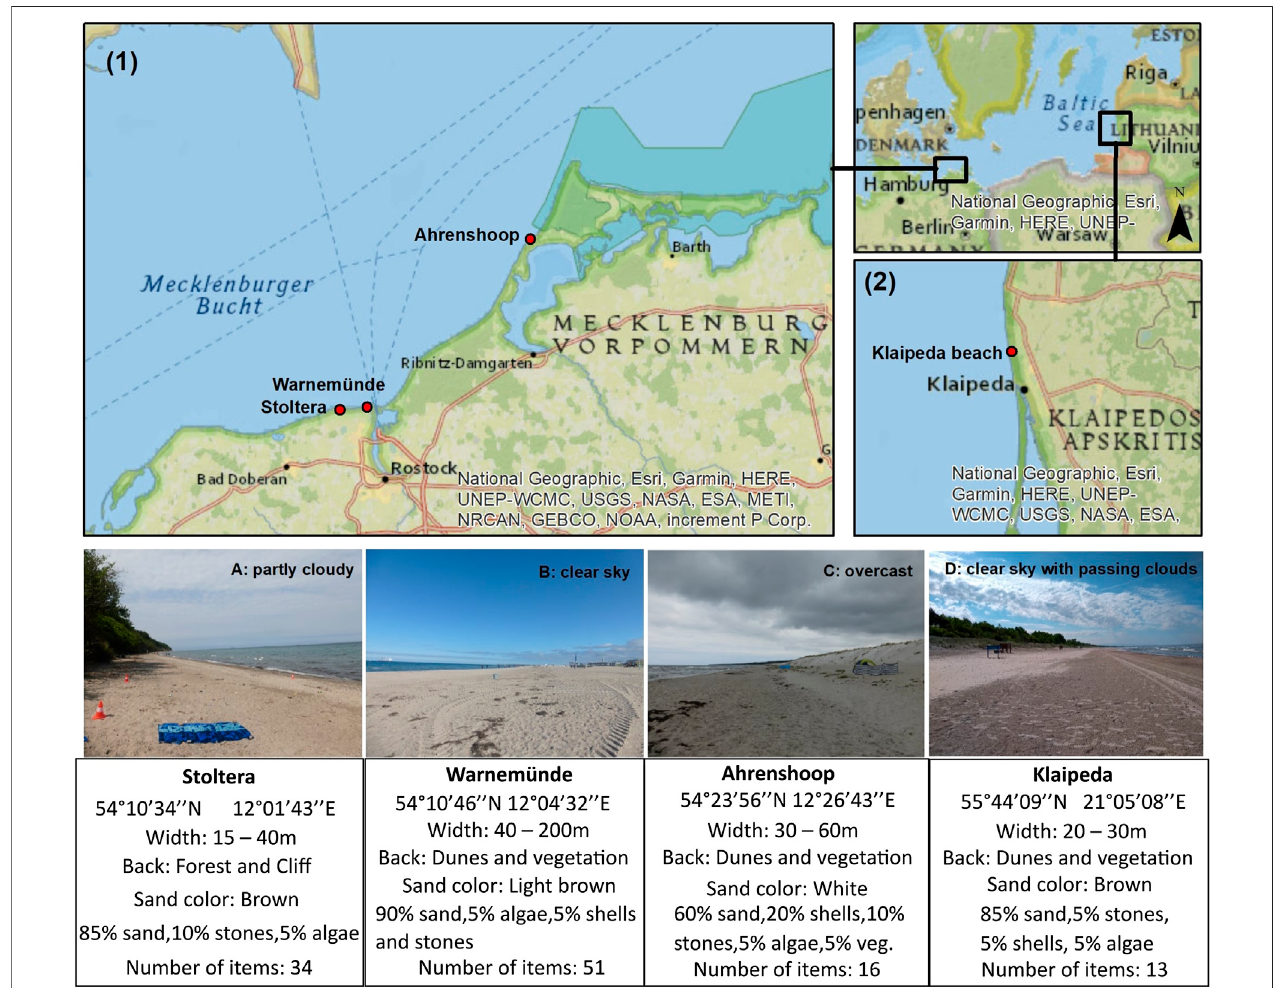
FIGURE 1 | Study sites for drone mapping and in-situ data collection of beach litter in the Southern Baltic Sea, speci fi cally Germany (1) (A) : Stoltera, (B) : Warnemünde, (C) : Ahrenshoop) and Lithuania (2) (D) : Klaipeda).